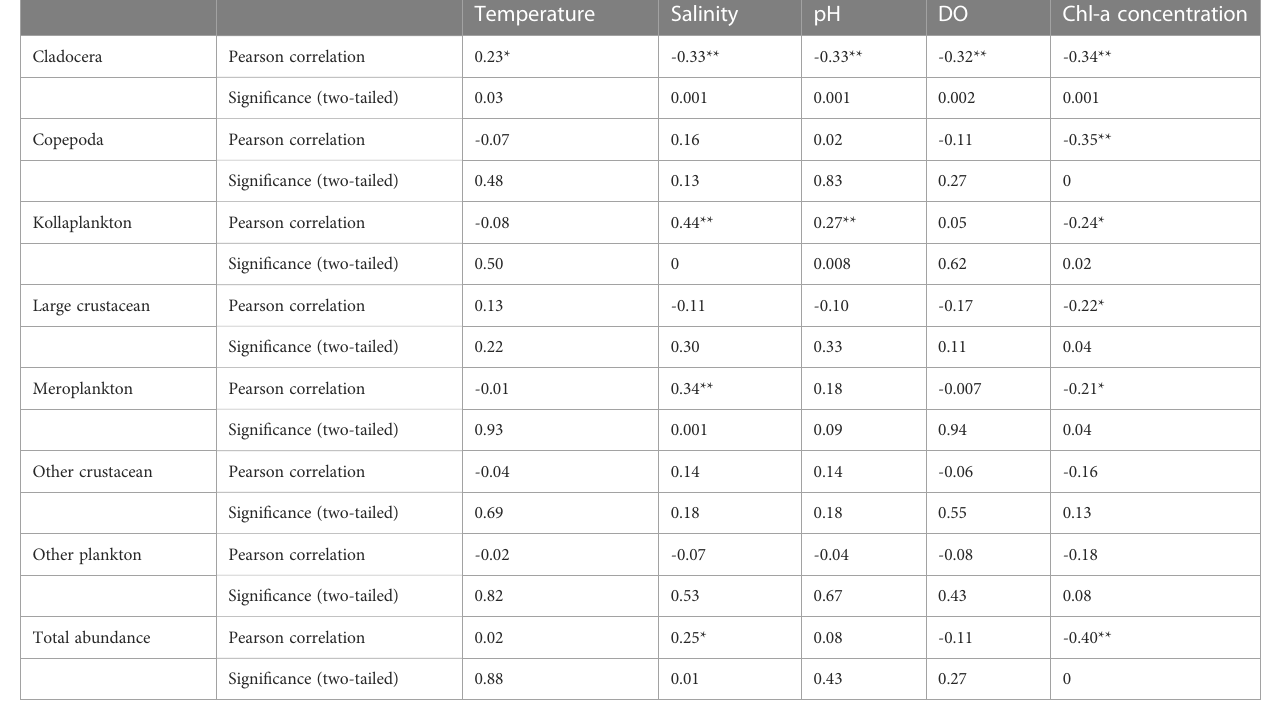
TABLE 1 Correlation analysis of environmental parameters with different functional groups in the research area.